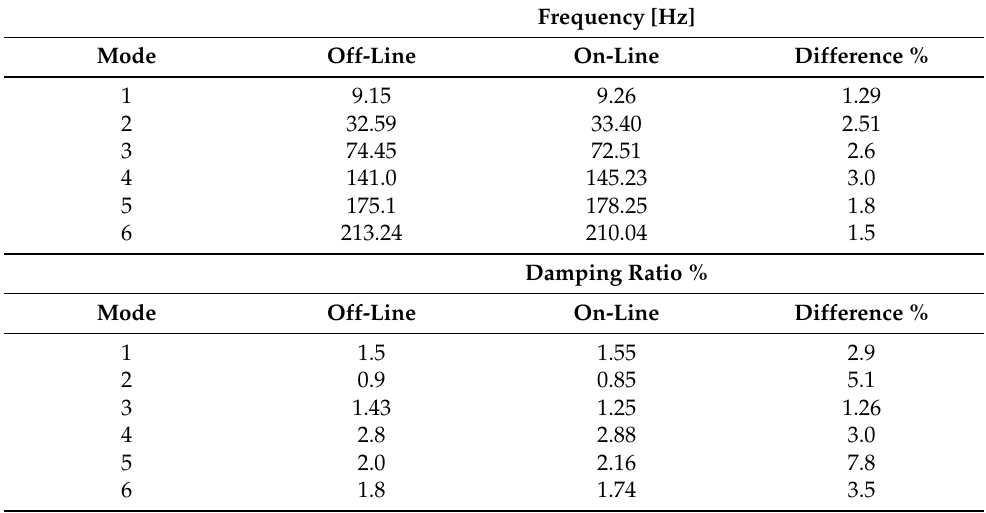
Table 3. Results summary and